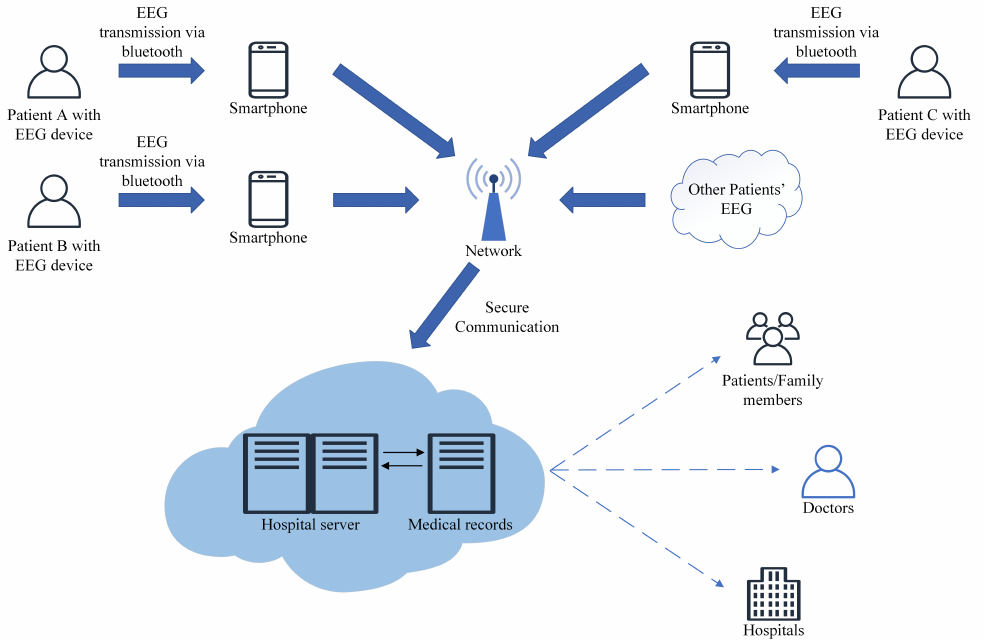
Figure 1. The smart IoT network framework for epileptic seizure prediction.